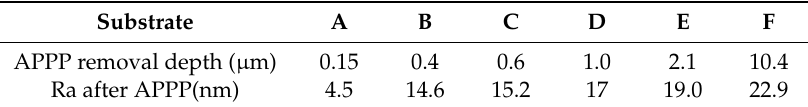
Table 3. Substrates details after APPP.